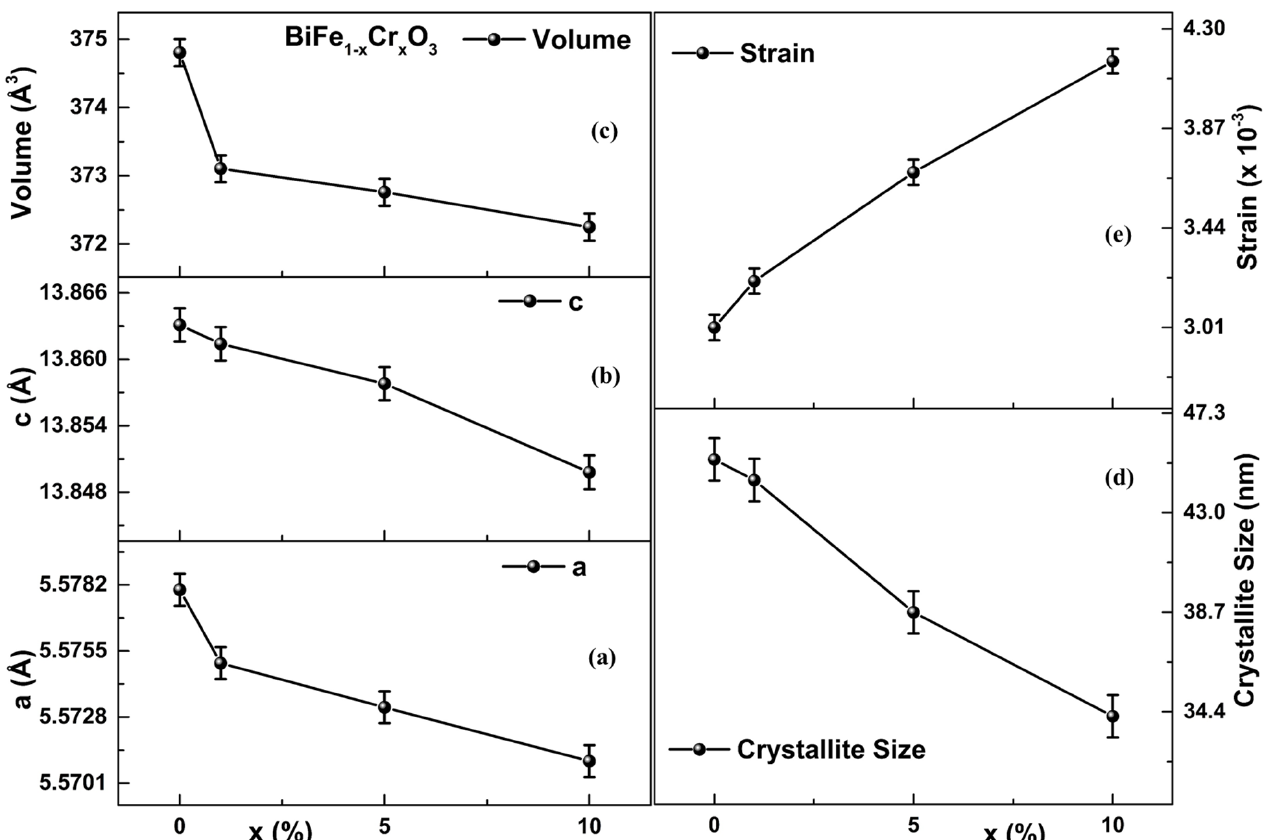
Figure 2. ( a – e ) Variations of lattice parameters ( a / c ), unit cell volume, crystallite size and strain as functions of Cr concentration.